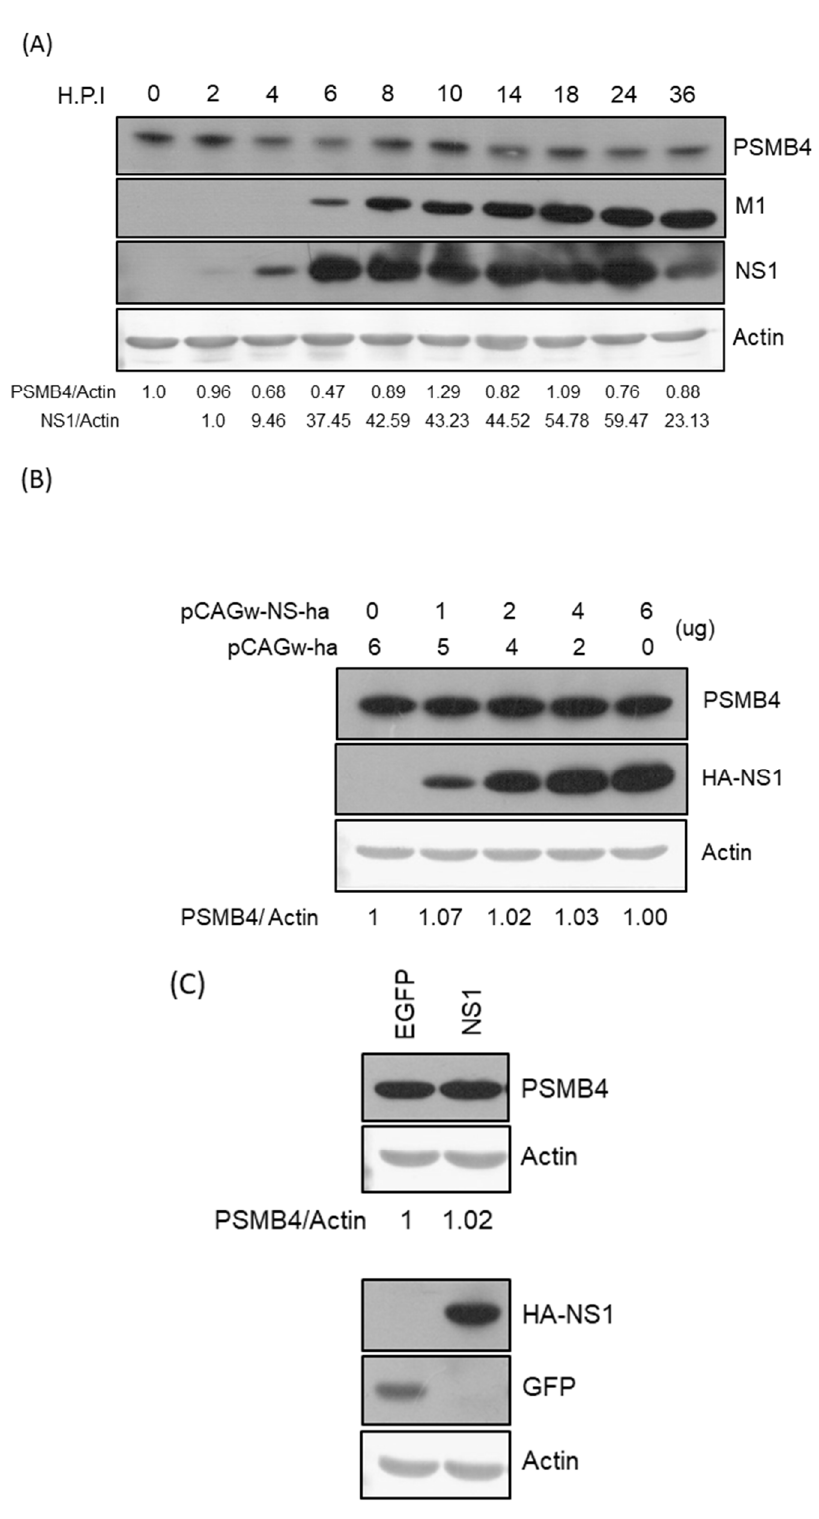
Figure 4. ( A ) Modulation of PSMB4 protein level by IAV infection. Cell lysates from A549 cells after infection with WSN 33 (H1N1) (MOI = 3) at different time points (hours post ‐ infection, h.p.i.) as indicated were analyzed by SDS ‐ PAGE and Western blotting against PSMB4 (upper panel), IAV M1 or NS1 protein (middle panels). Actin was used as the loading control (bottom panel). ( B ) Transiently expressed NS1 protein did not affect the endogenous PSMB4 protein level. Cell lysates from A549 cells transfected with plasmids encoding HA ‐ tagged NS1 or empty vectors were ana ‐ lyzed by SDS ‐ PAGE and Western blotting against PSMB4 (upper panel), HA tag (for exogenous